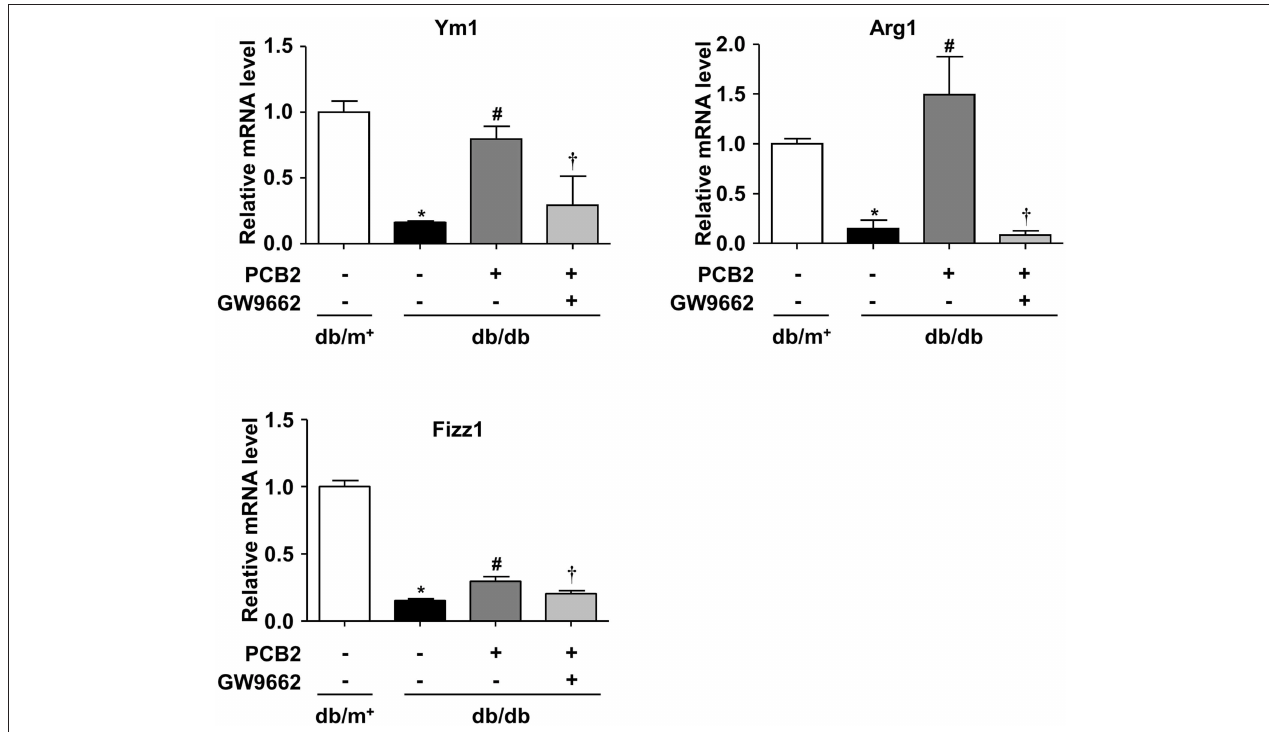
FIGURE 6 | PCB2 ameliorated impaired M2 polarization via PPAR γ activation. PCMs isolated from db/db or db/m + mice were pre-treated with or without GW9662 (5 µ M) for 1h, then exposed to PCB2 (10 µ M) for 24h. The mRNA levels of Ym1, Arg1, and Fizz1 were measured by qRT-PCR. Data were shown as mean ± SEM, n = 6, * P < 0.05 vs. db/m + treated with vehicle; # P < 0.05 vs. db/db treated with vehicle; † P < 0.05 vs. db/db treated with